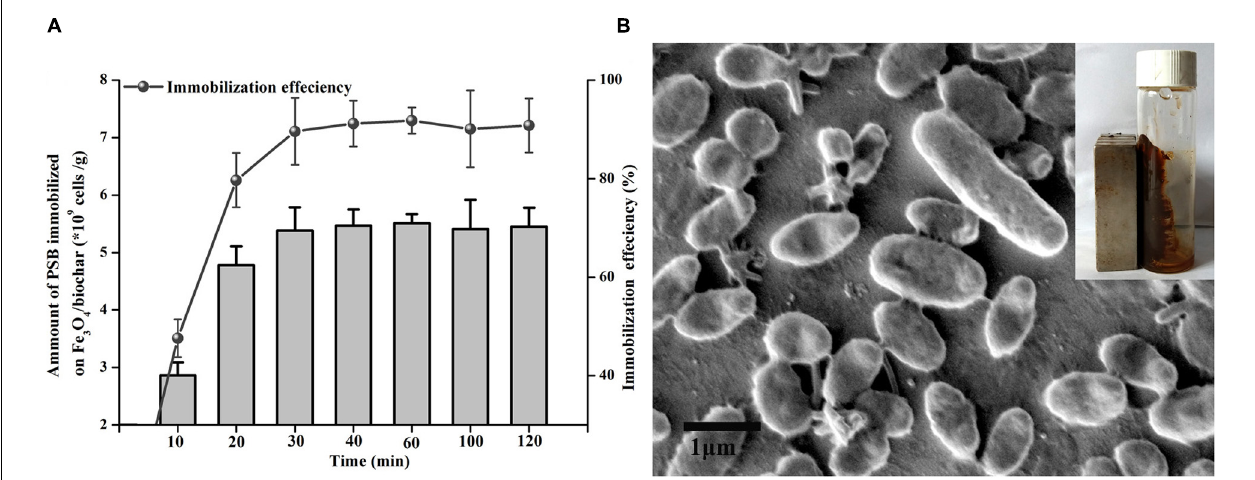
FIGURE 4 | (A) The amount of immobilized PSB bacteria (bar), as well as the immobilization efficiency (line), on Fe 3 O 4 /biochar, and (B) SEM image of immobilized PSB bacteria, the insert shows the magnetic property of immobilized bacteria.